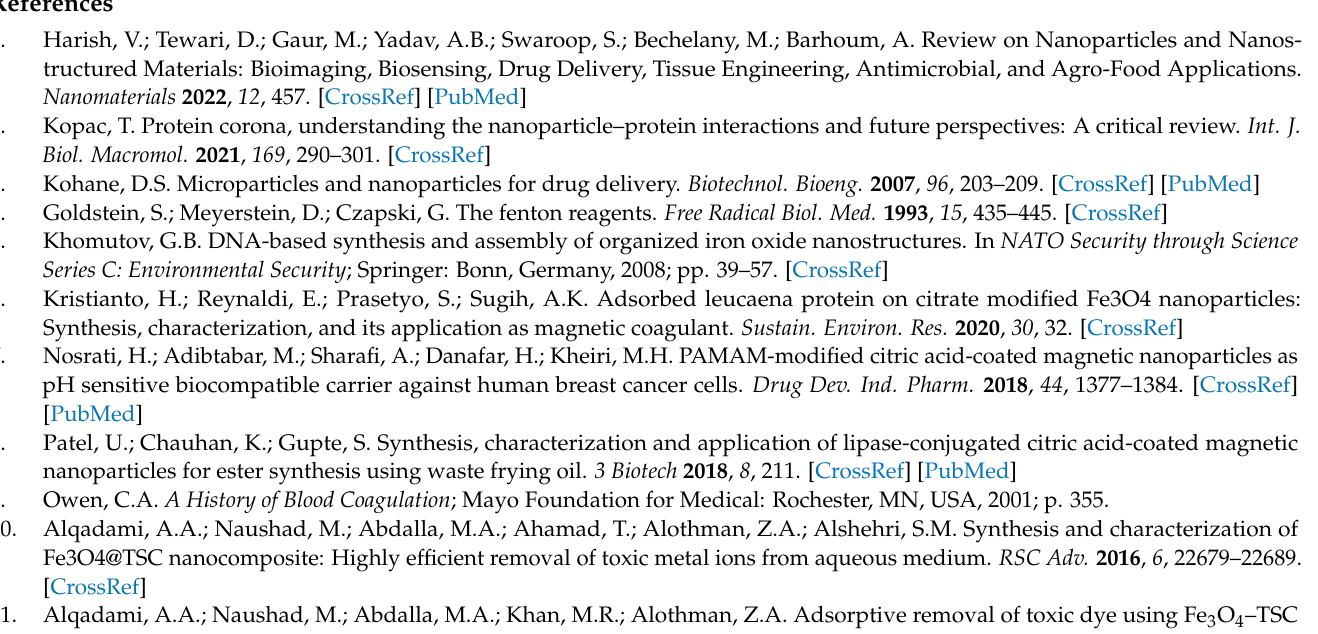
with different concentrations; Table S3: Settings of the fluorimeter Jasco FP-8300 for Figure 5b–f main article; Table S4: Settings of the fluorimeter Jasco FP-8300 for Figures